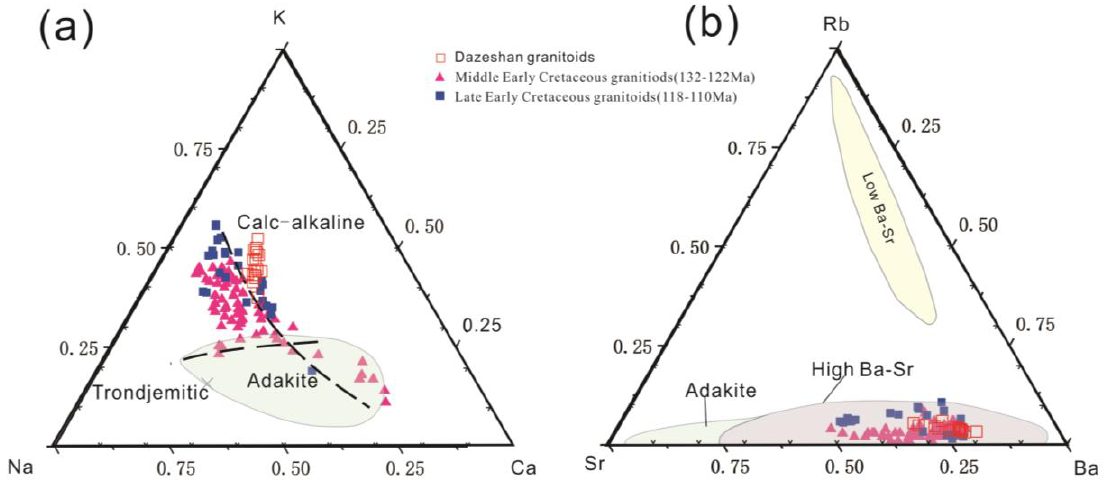
Figure 9. ( a ) Na-K-Ca and ( b ) Sr-Rb-Ba plots for the Dazeshan granitoids based on [16]. The pub- lished data for middle Early Cretaceous granitoids (132 – 122 Ma) [64 – 67] and Late Early Cretaceous granitoids (118 – 110 Ma) [49 – 50,68] are also shown in the Figures. Fields of low-Ba – Sr and high-Ba – Sr granitoids are from [76], and the field of adakite is from [17].